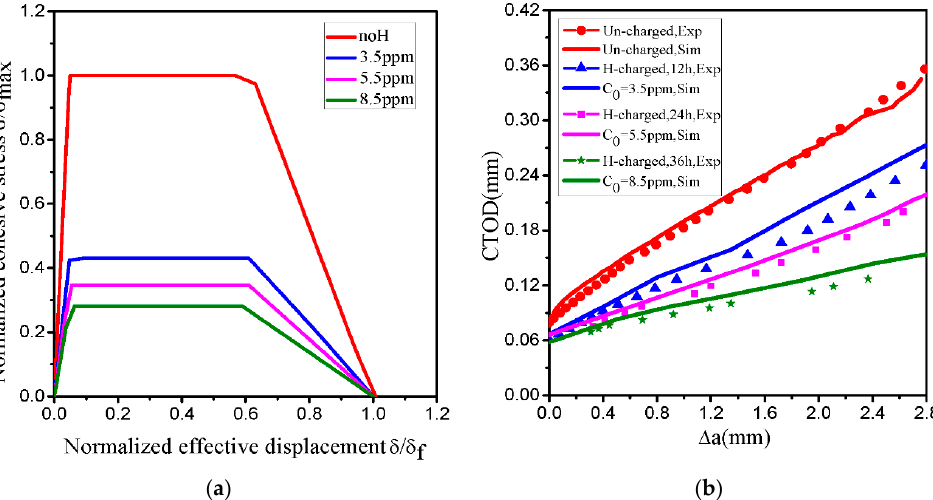
Figure 16. ( a ) TSL at various C L 0 (0.0, 3.5, 5.5, and 8.5 ppm); ( b ) CTOD-R curves from experimental data and results of numerical simulations. (Exp: experiment; Sim: simulation)